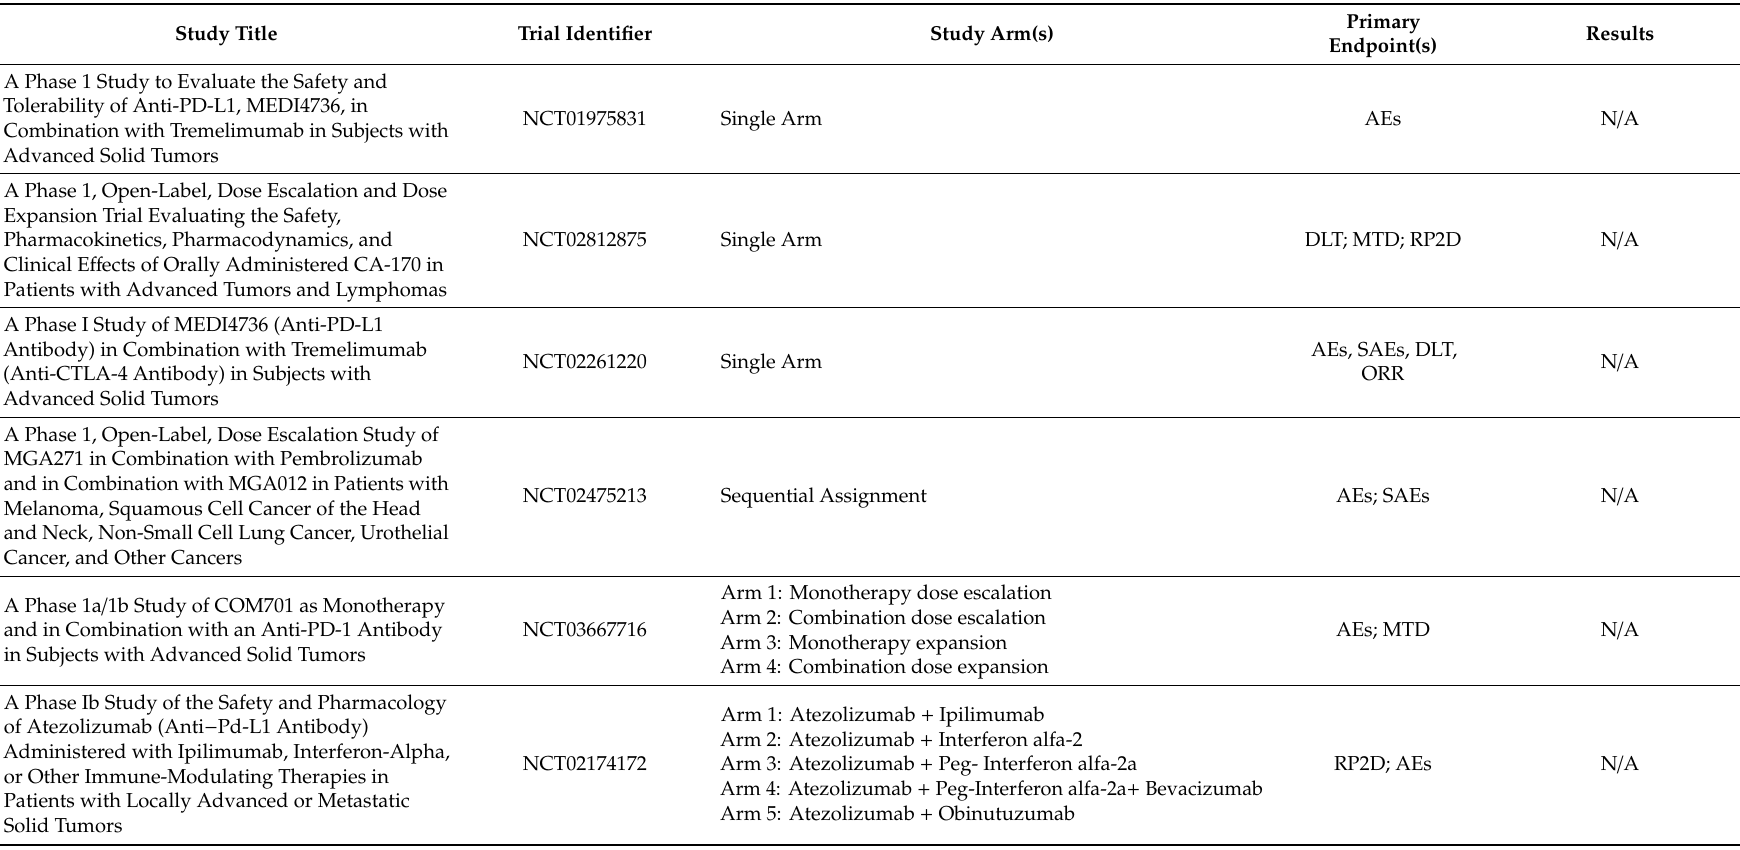
Table 4. PD-1 and additional immune